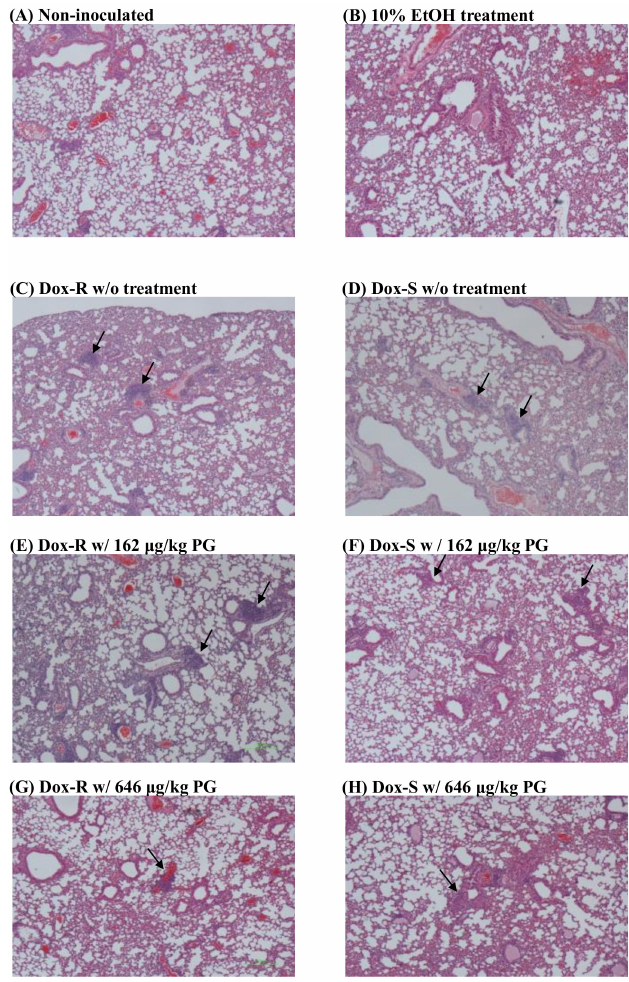
Figure 8. In situ xenograft tumor after PG treatments. Lung tumor ( A ) without tumor injection, with tumor injection and treated with ( B ) 10% EtOH, ( C , D ) untreated, ( E , F ) 162 µ g/kg PG, and ( G , H ) 646 µ g/kg PG and stained with hematoxylin and eosin. All tissue snapshots were taken in 10 × 10. Black arrow points to the location of tumor